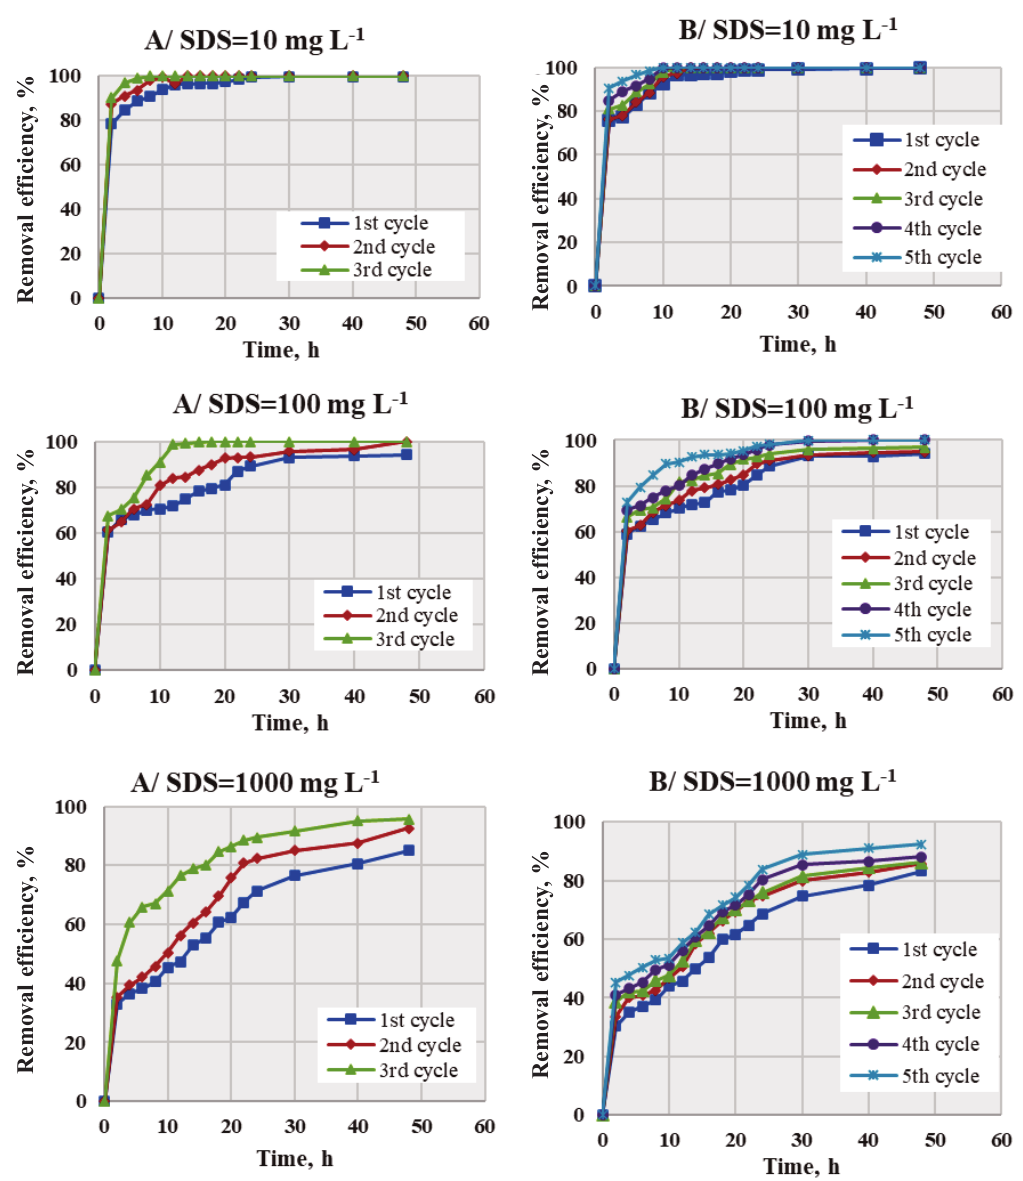
Fig. 4 – Recycling of beads for SDS biodegradation in synthetically prepared solution; (a) SA beads (b) SA-PVA